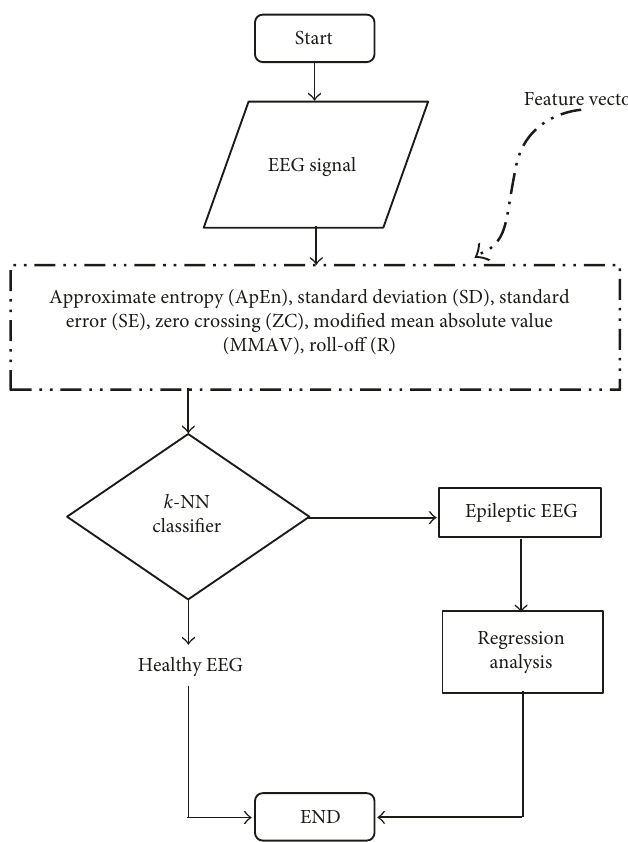
Figure 4: Proposed fl ow diagram of the research work. Table 1: Training and testing template of feature vectors of epileptic EEG data. Subjects of train or